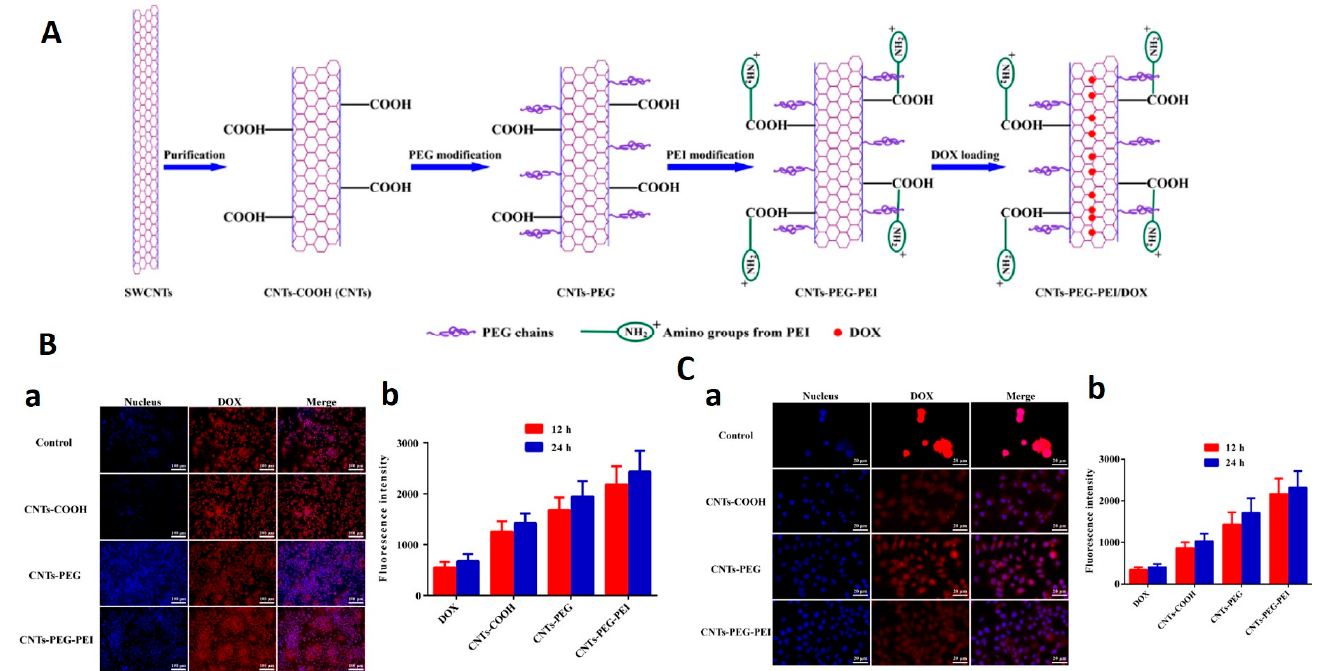
Figure 9. ( A ) Schematic representation of CNT-PEG-PEI nanocarriers and the drug-loading process. ( B ) ( a ) Fluorescence images of MCF-7 cells after treatment with free DOX (control) and different DOX-loaded nanocarrier formulations for 12 h. ( b ) Fluorescence intensity of free DOX and different DOX-loaded nanocarrier formulations ( n = 3). Student t -test was used for statistical analysis. ( C ) ( a ) Confocal microscopy images of MCF-7 cells after treatment with free DOX (control) and different DOX-loaded nanocarrier formulations for 12 h. ( b ) Quantitative fluorescence intensity of free DOX and different DOX-loaded nanocarrier formulations ( n = 3). Student t -test was used for statistical analysis [75].